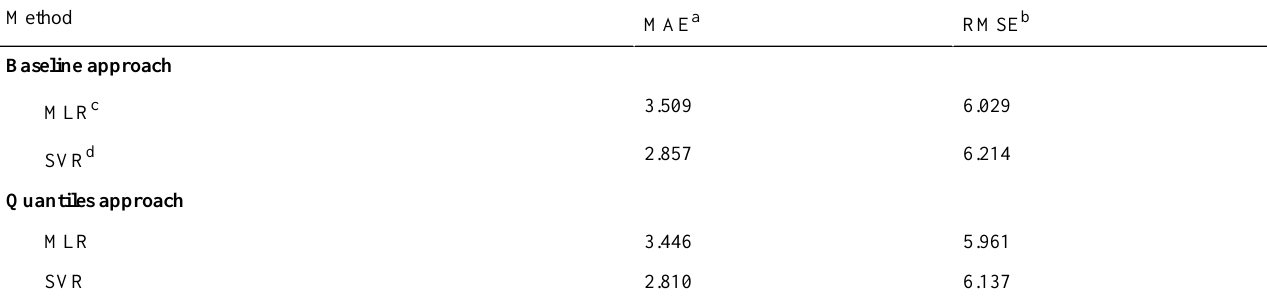
Table 12. Regression error values of the length of stay model using the baseline and quantile approaches.